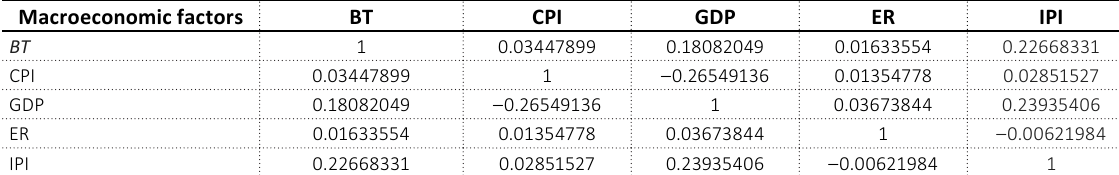
Table 4. Results of macroeconomic factors impact on Palestine market index